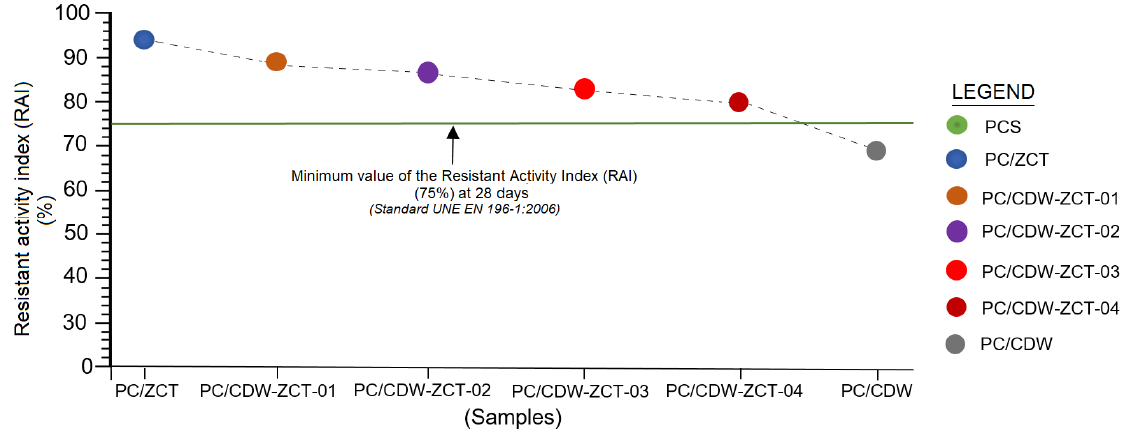
Figure 5. Variations in the Resistant Activity Index (RAI) of specimens made with PC/ZCT, PC/CDW-ZCT (01 to 04) and PC/CDW, in relation to 75% of the value of the compressive strength of the PCS specimen.